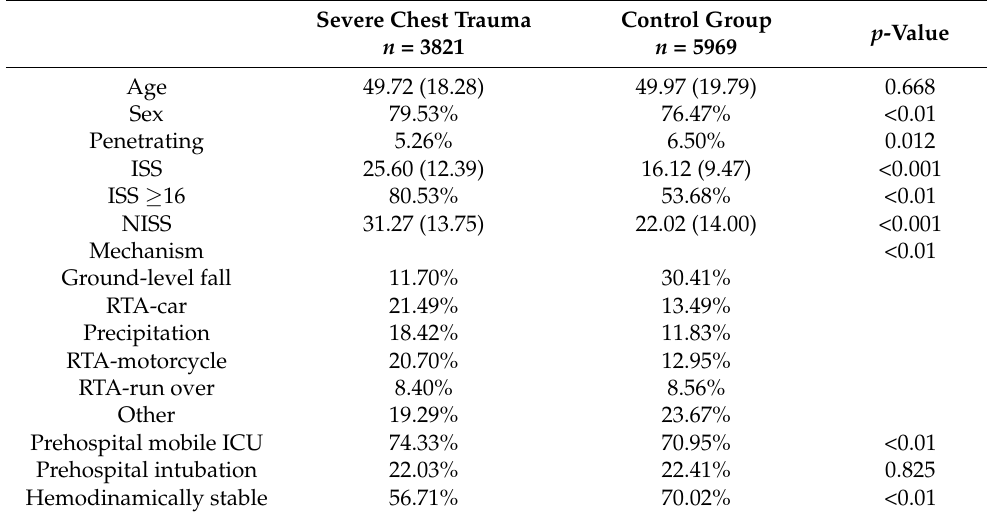
Table 1. Baseline characteristics of the population with severe chest trauma and the control